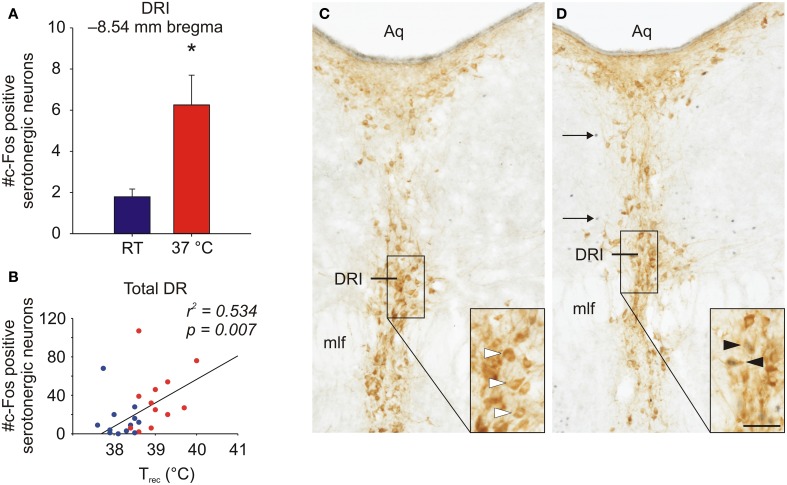
Graphs illustrating effects of exposure of rats to warm ambient temperature on serotonergic neurons in the interfascicular part of the dorsal raphe nucleus (DRI). Rats were exposed to either room temperature (RT; 23°C) or (37°C) for 105 min. (A) Exposure to warm ambient temperature, relative to RT control conditions, activated DRI serotonergic neurons, as measured by double immunohistochemical staining of c-Fos, the protein product of the immediate-early gene, c-fos. (B) Scatter plot depicting the relationship between the post-whole body heating rectal temperature (Trec) of individual rats and the number of c-Fos-immunoreactive (ir) serotonergic neurons for all sampled subdivisions of the dorsal raphe nucleus (total DR). (C,D) Photomicrographs illustrating c-Fos and tryptophan hydroxylase (TPH) immunostaining in the dorsal raphe nucleus. Panels illustrate the DRI at −8.54 mm bregma of a rat exposed to (C) room temperature (RT) or (D) 37°C ambient temperature for 105 min. Black boxes in (C) and (D) indicate regions shown at higher magnification in insets in the lower right corner of each panel. White arrowheads indicate c-Fos-immunonegative/TPH-immunoreactive (ir) neurons, black arrowheads indicate c-Fos-ir/TPH-ir neurons and black arrows indicate c-Fos-ir/TPH-immunonegative cells. Abbreviations: Aq, cerebral aqueduct; mlf, medial longitudinal fasciculus. Scale bar, 100 μm (A,B), and 50 μm, insets. Adapted from Hale et al. (2011), with permission.